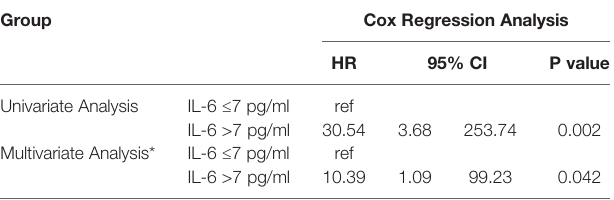
TABLE 4 | The risk of elevated IL-6 for mortality of COVID-19.